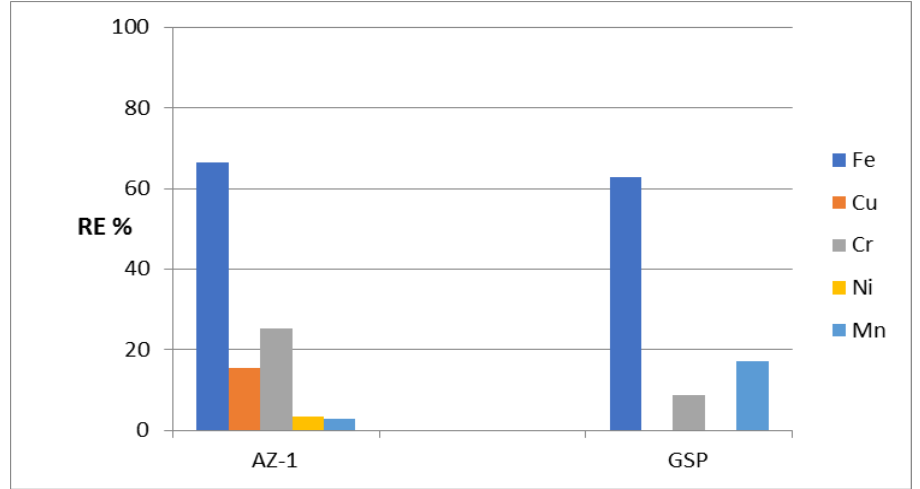
Table 2. Original concentrations of some heavy metals in the analyzed mixed standard.